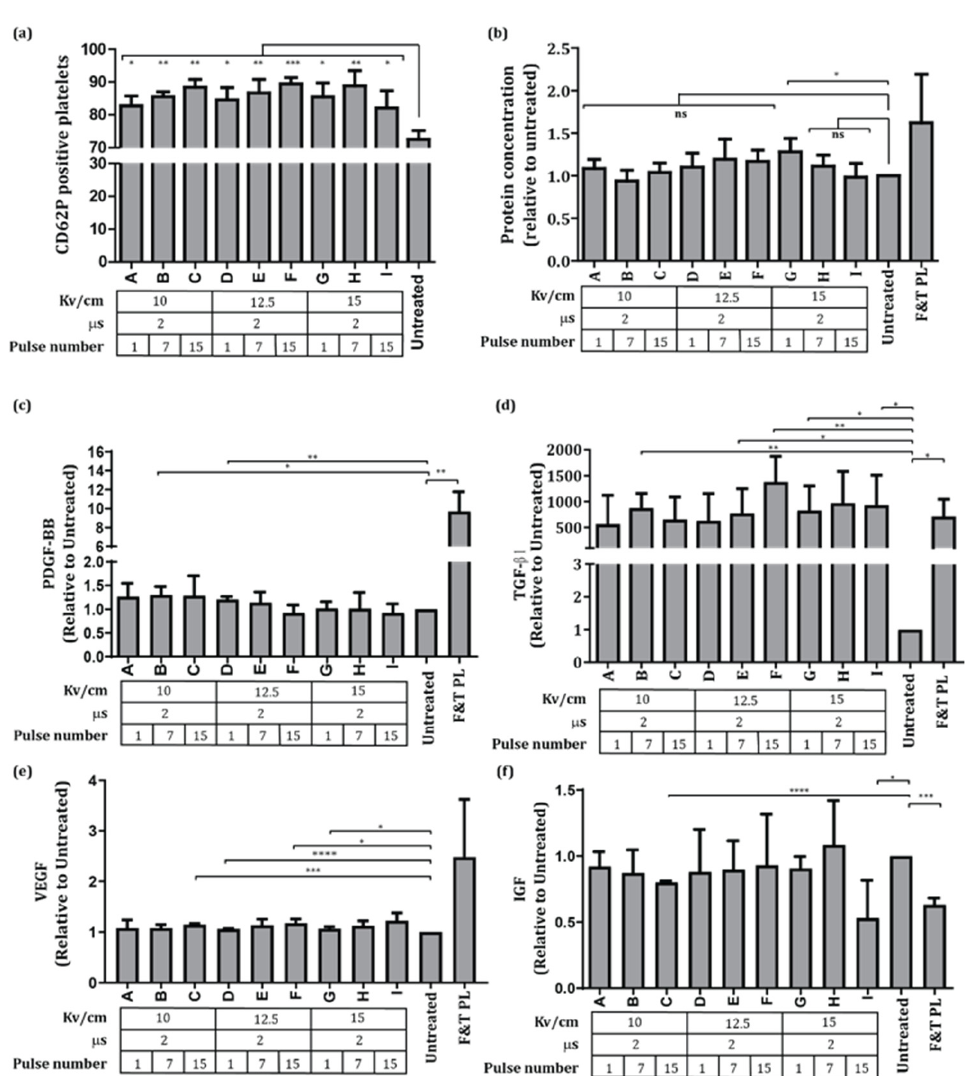
Figure 2. Characterization of platelet activation and PR after PEF application to PCs. ( a ) Percentage of CD62P positive platelets after PEF treatment. ( b ) Total PR protein after PEF application. ( c ) PDGF-BB, ( d ) TGF- β 1, ( e ) VEGF, and ( f ) IGF released to PR after application of PEF. Results plotted relative to the untreated condition. Mean ± SD is shown. n = 3. ns = non-significant. * p < 0.05, ** p < 0.01, *** p < 0.001, **** p < 0.0001.